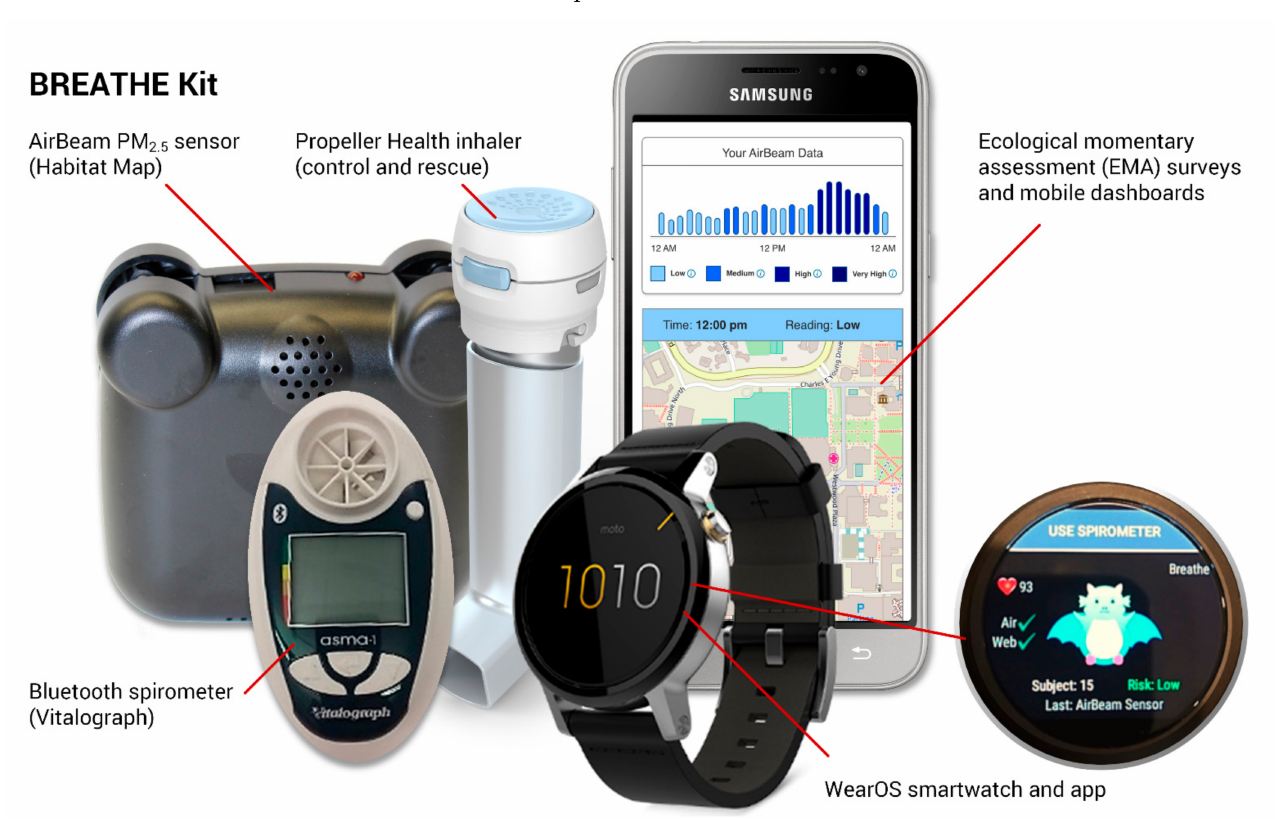
Figure 1. The Biomedical REAL-Time Health Evaluation (BREATHE) Kit developed in the Los Angeles PRISMS